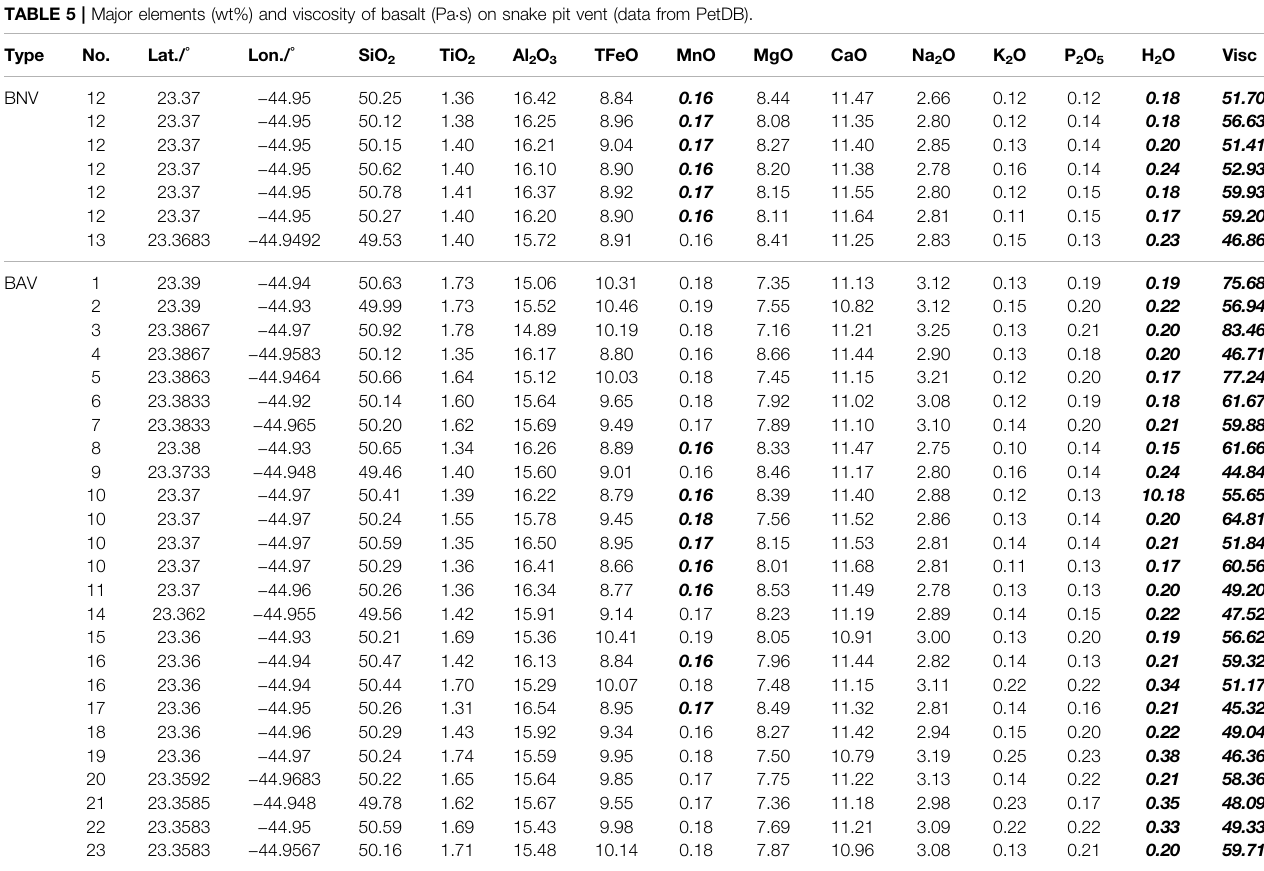
TABLE 5 | Major elements (wt%) and viscosity of basalt (Pa · s) on snake pit vent (data from